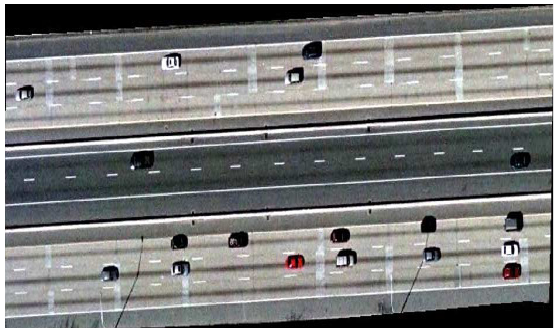
Figure 1: Highway image of of 0.15 m resolution [courtsey: Zheng,Z. et al . (2013)]